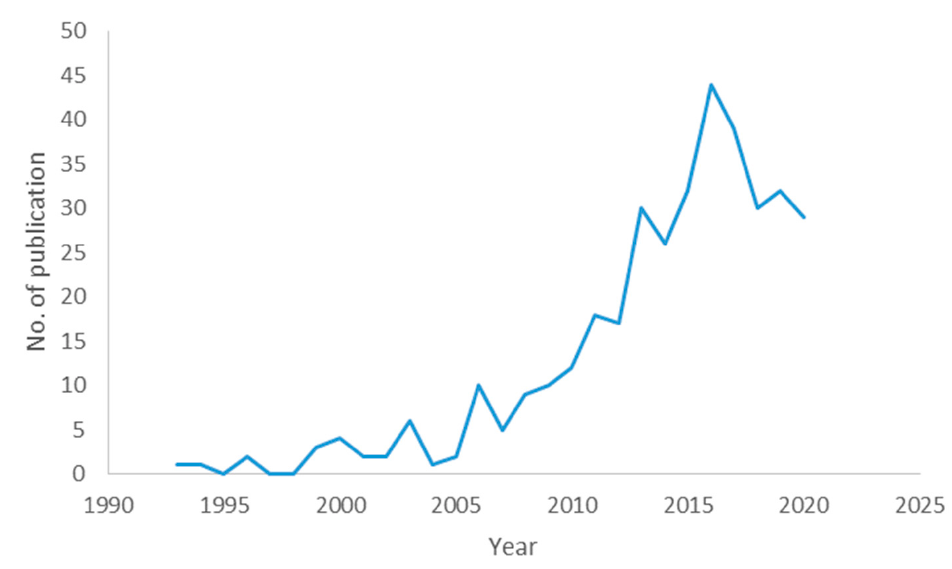
Figure 1. All published articles from 1995 to 2020 in an analyzed sample of 367 articles. In the analyzed sample, articles constituted 68%, and reviews accounted for 17% (Figure 2).